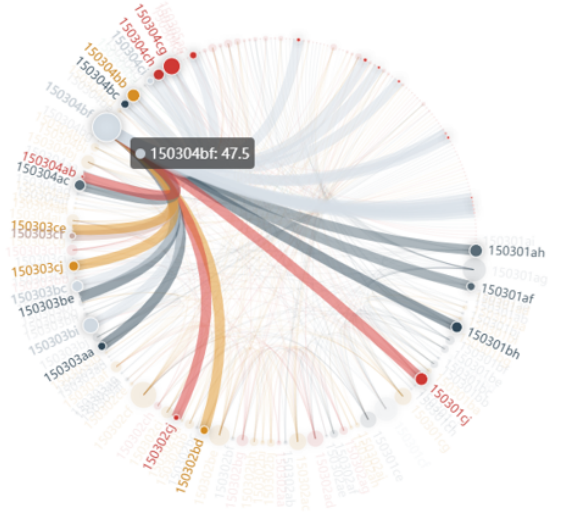
Figure 6. Chord diagram representing social relationship of student